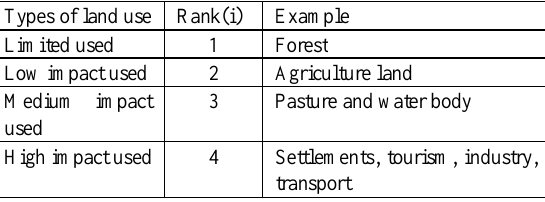
Table1. Correspond between types and ranks of land use.